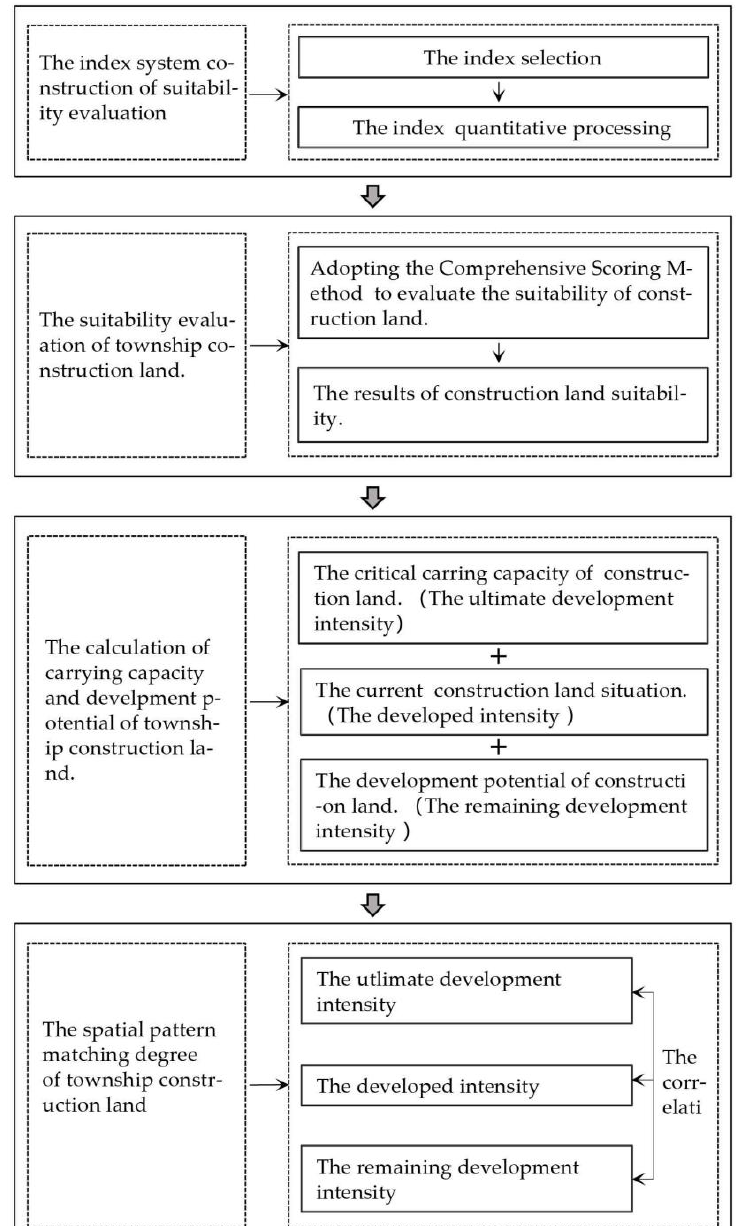
Figure 2. The process of the research of township construction land carrying capacity and spatial matching in Xifeng.